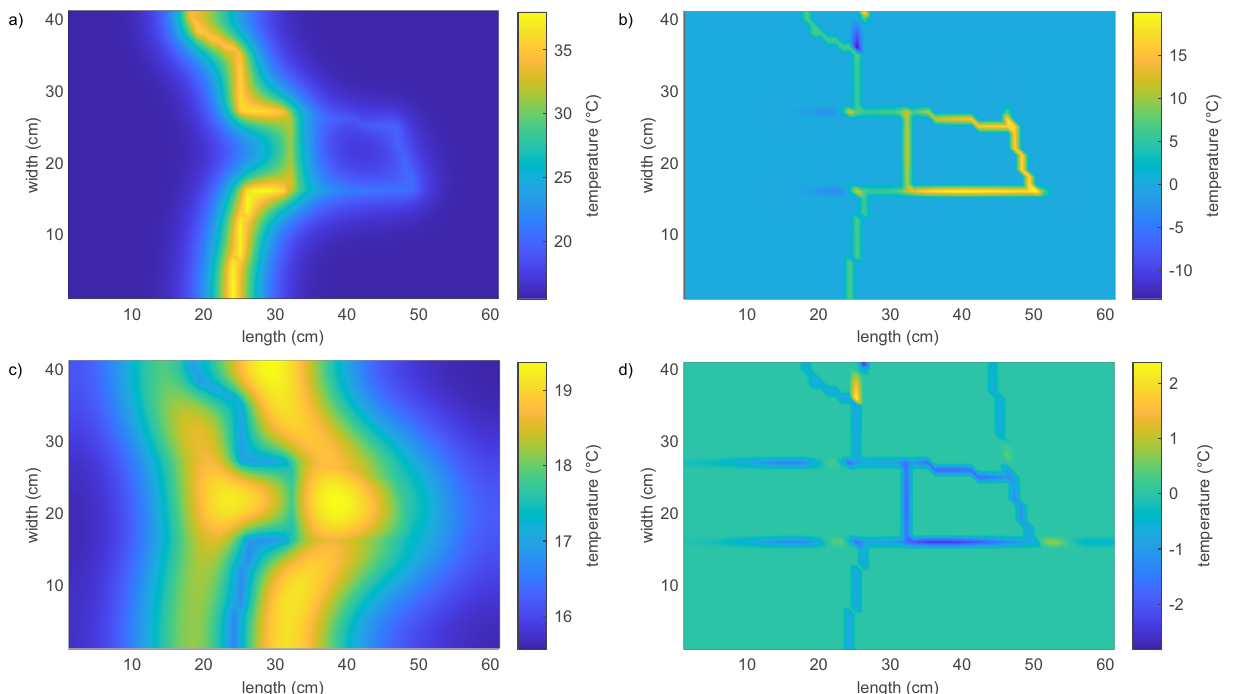
Fig. 3 | Temperature distribution. Calculated rock temperatures ( a , c ) and dif- ferencebetweenwaterandrocktemperatures( b , d )forsnapshotsat1000s( a , b ), closetotheendof theinjectedtemperature pulse,and3000s( c , d )afterthestart